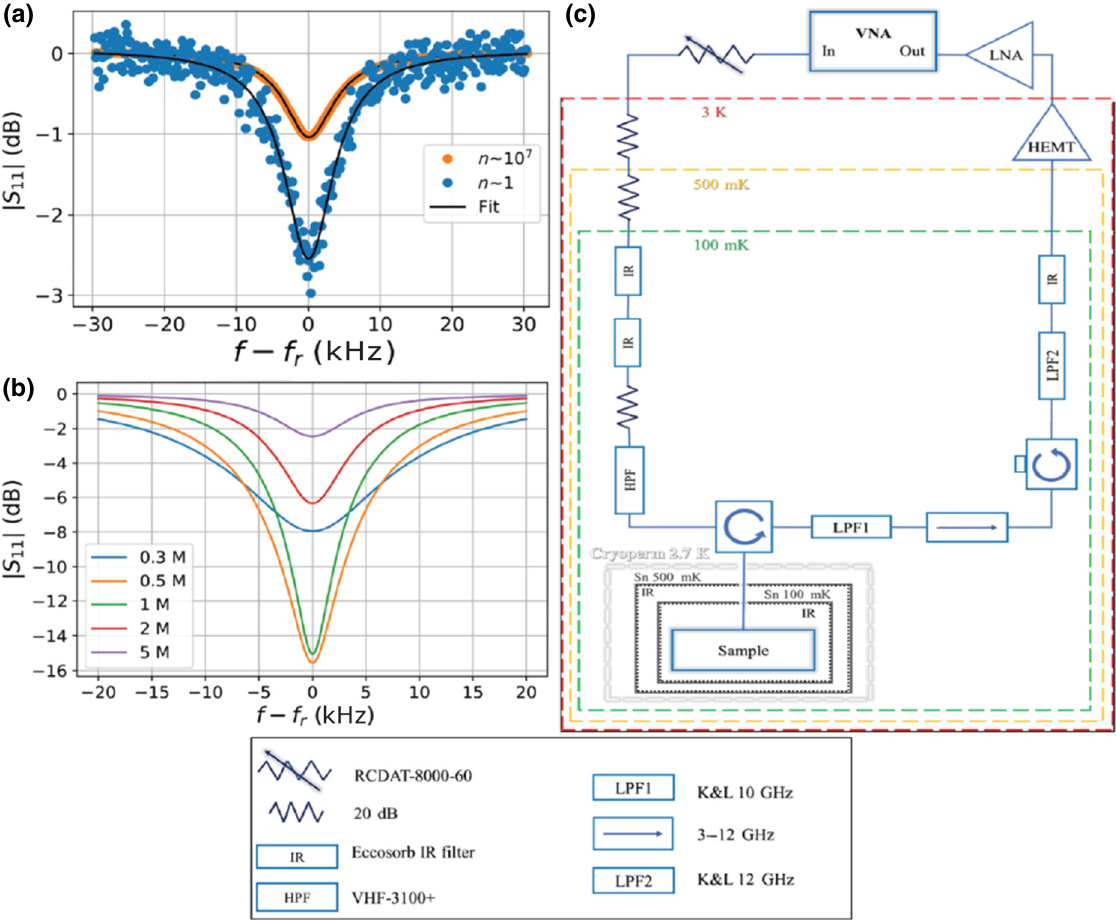
FIG. 18. (a) The reflected signal, after normalization for A and τ , at high power and in the single-photon region for one of the best standard resonators (R6). There is no significant asymmetry in the background. (b) Plots of | S 11 | calculated for several values of Q int with Q ext = 0.7 M . The power dip is maximized for Q int ≈ Q ext . The full width at half maximum increases for Q int < Q ext , and approaches a minimum for Q int > Q ext . (c) A schematic of the ADR thermal and radiation shielding and microwave components for reflectometry. The resistor symbols represent thermalized attenuators and IR, HPF, and LPF are infrared, high-pass, and low-pass